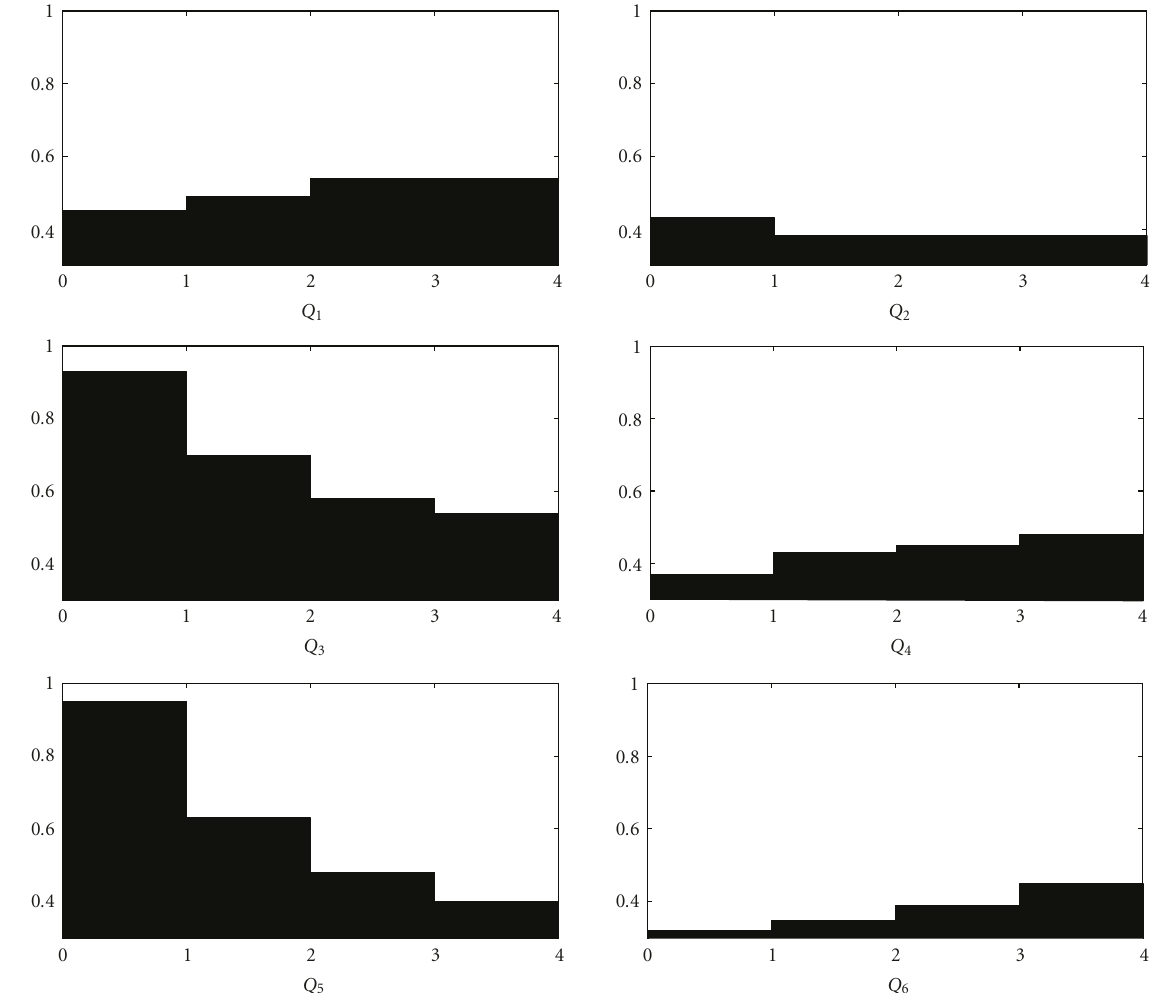
Figure 8: The variation of the Q factors due to the adjustment of the k